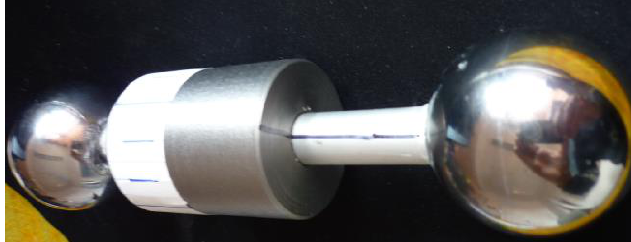
Figure 18. Maintaining the position of the center of mass of the rotor with respect to the axis of symmetry of the rotor.